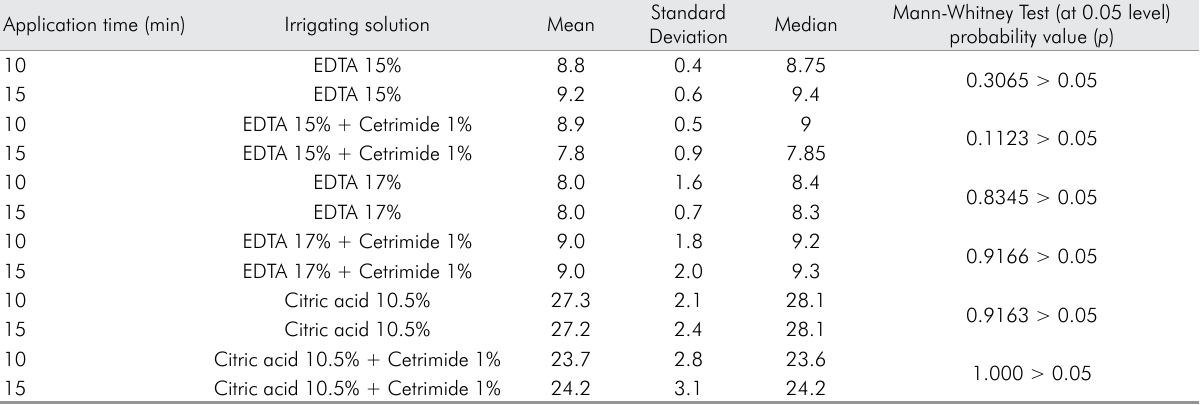
Table 2. Comparison of calcium released (mg/l) from root canal dentin after 10 and 15 minutes treatment with tested irrigating solutions: results of the Mann-Whitney test.